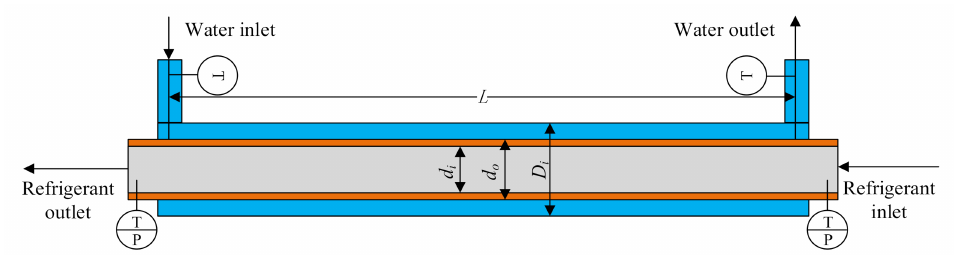
Figure 2. Schematic diagram of the test section of the experimental setup.